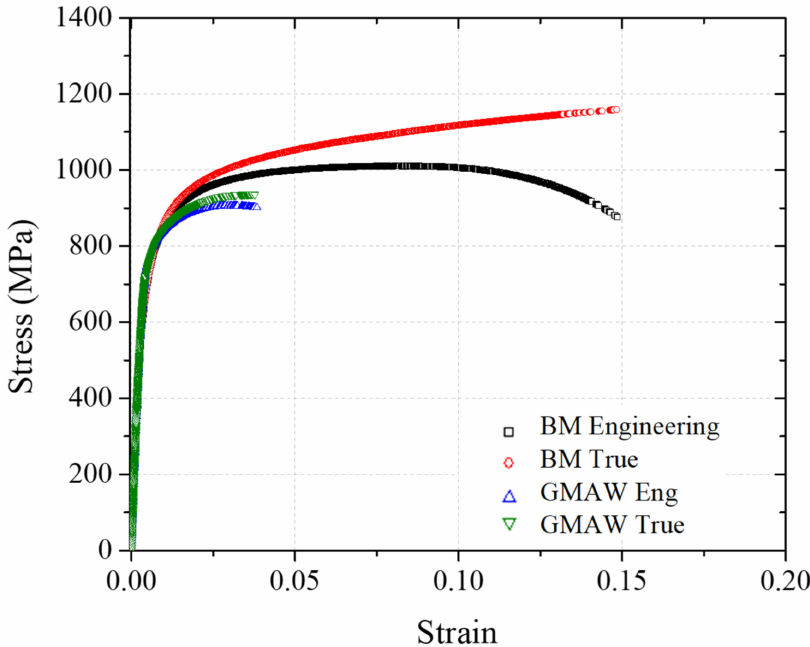
Figure 8. Tensile test stress-strain behavior for the base metal and welded joint of DP980 steel.